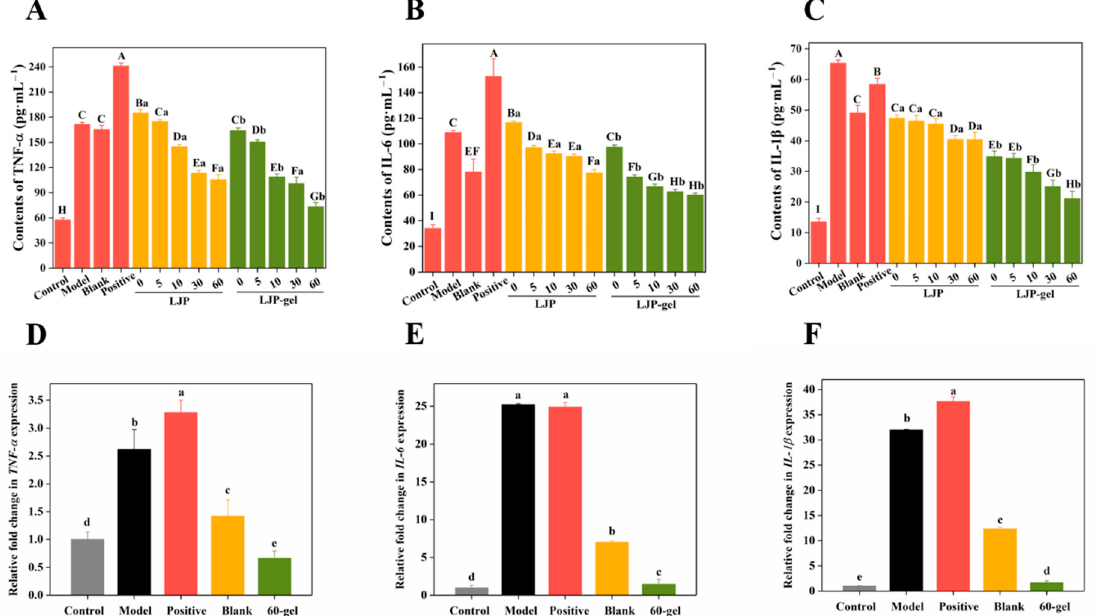
Figure 4. The levels of TNF- α ( A ), IL-6 ( B ), and IL-1 β ( C ) secreted by HaCaT cells after LJP and LJP-gels treatment. The gene expressions of TNF- α ( D ), IL-6 ( E ), and IL-1 β ( F ) in HaCaT cells after LJP-gels treatment. A–I Values with different letters are significantly different ( p < 0.05). a–e Values represent the significant difference between LJP and LJP-gel at the same degradation time ( p < 0.05).